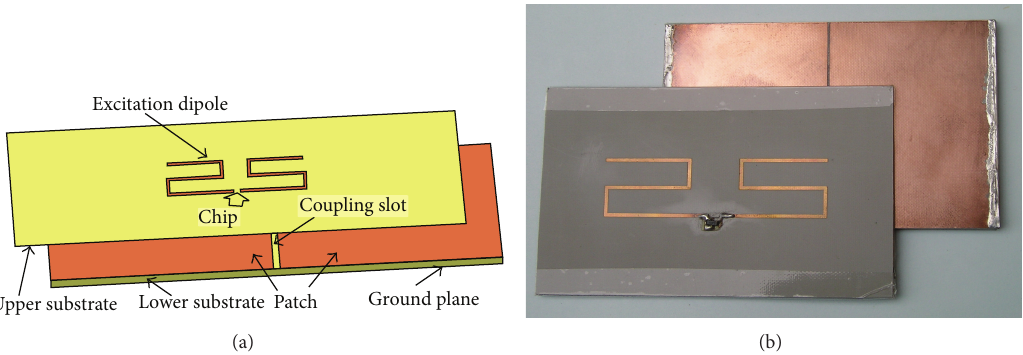
Figure 4: A sketch and a photograph of a dipole-excited coupled shorted-patches antenna.